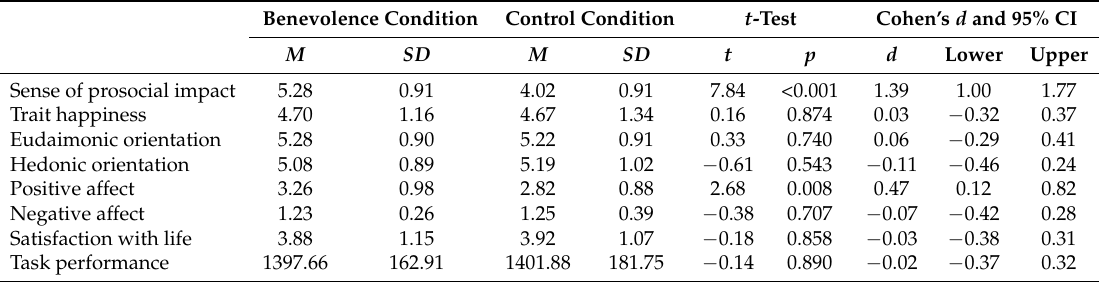
Table 2. Comparison between the benevolence and control conditions Benevolence Condition Control Condition t -Test Cohen’s d and 95% CI M